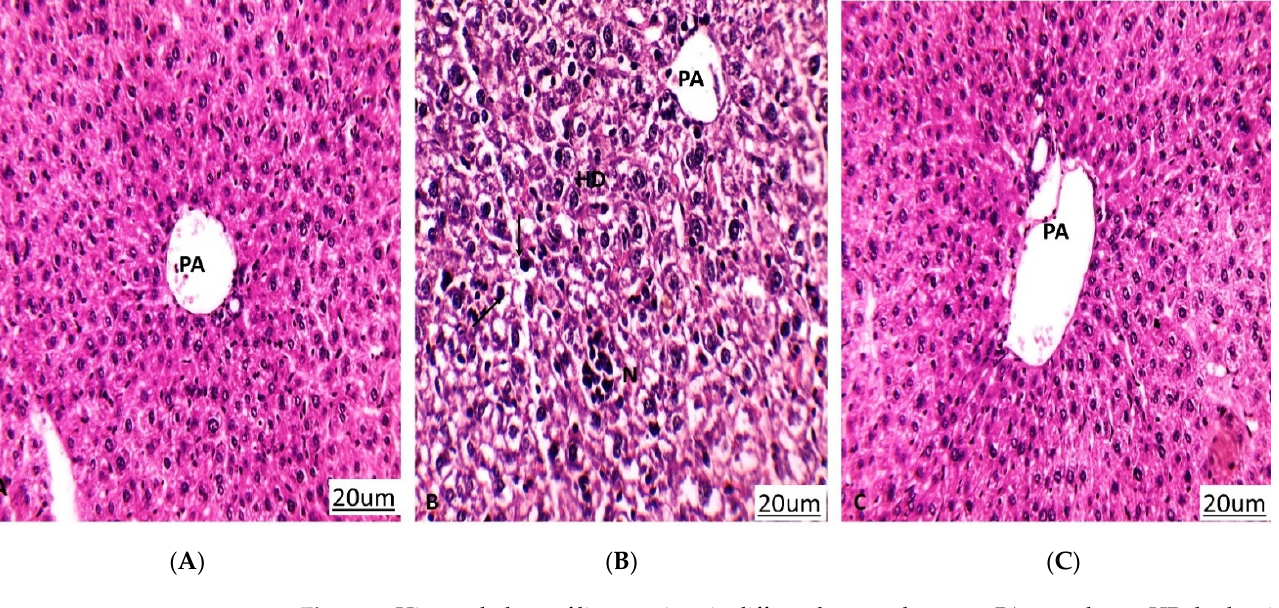
Table 3. LC-MS/MS metabolomic analysis of the ethanolic crude extract of A. judaica L.